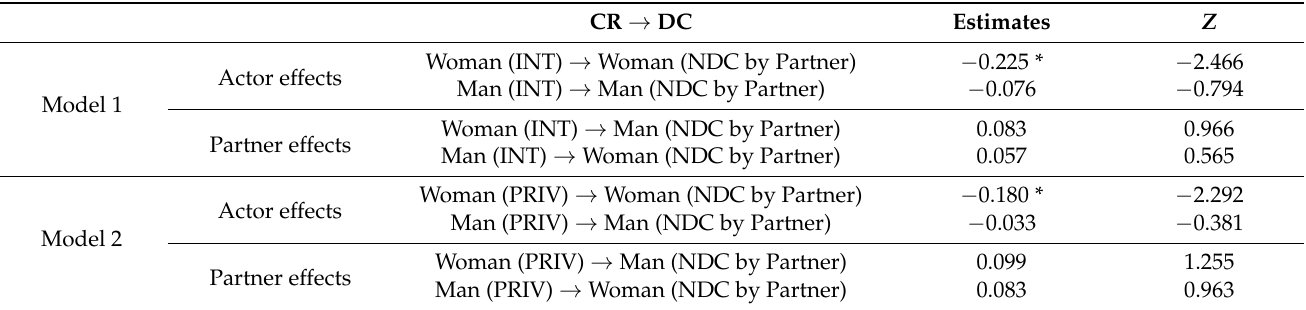
Table 4. Significant religiosity effects on dyadic coping in women.